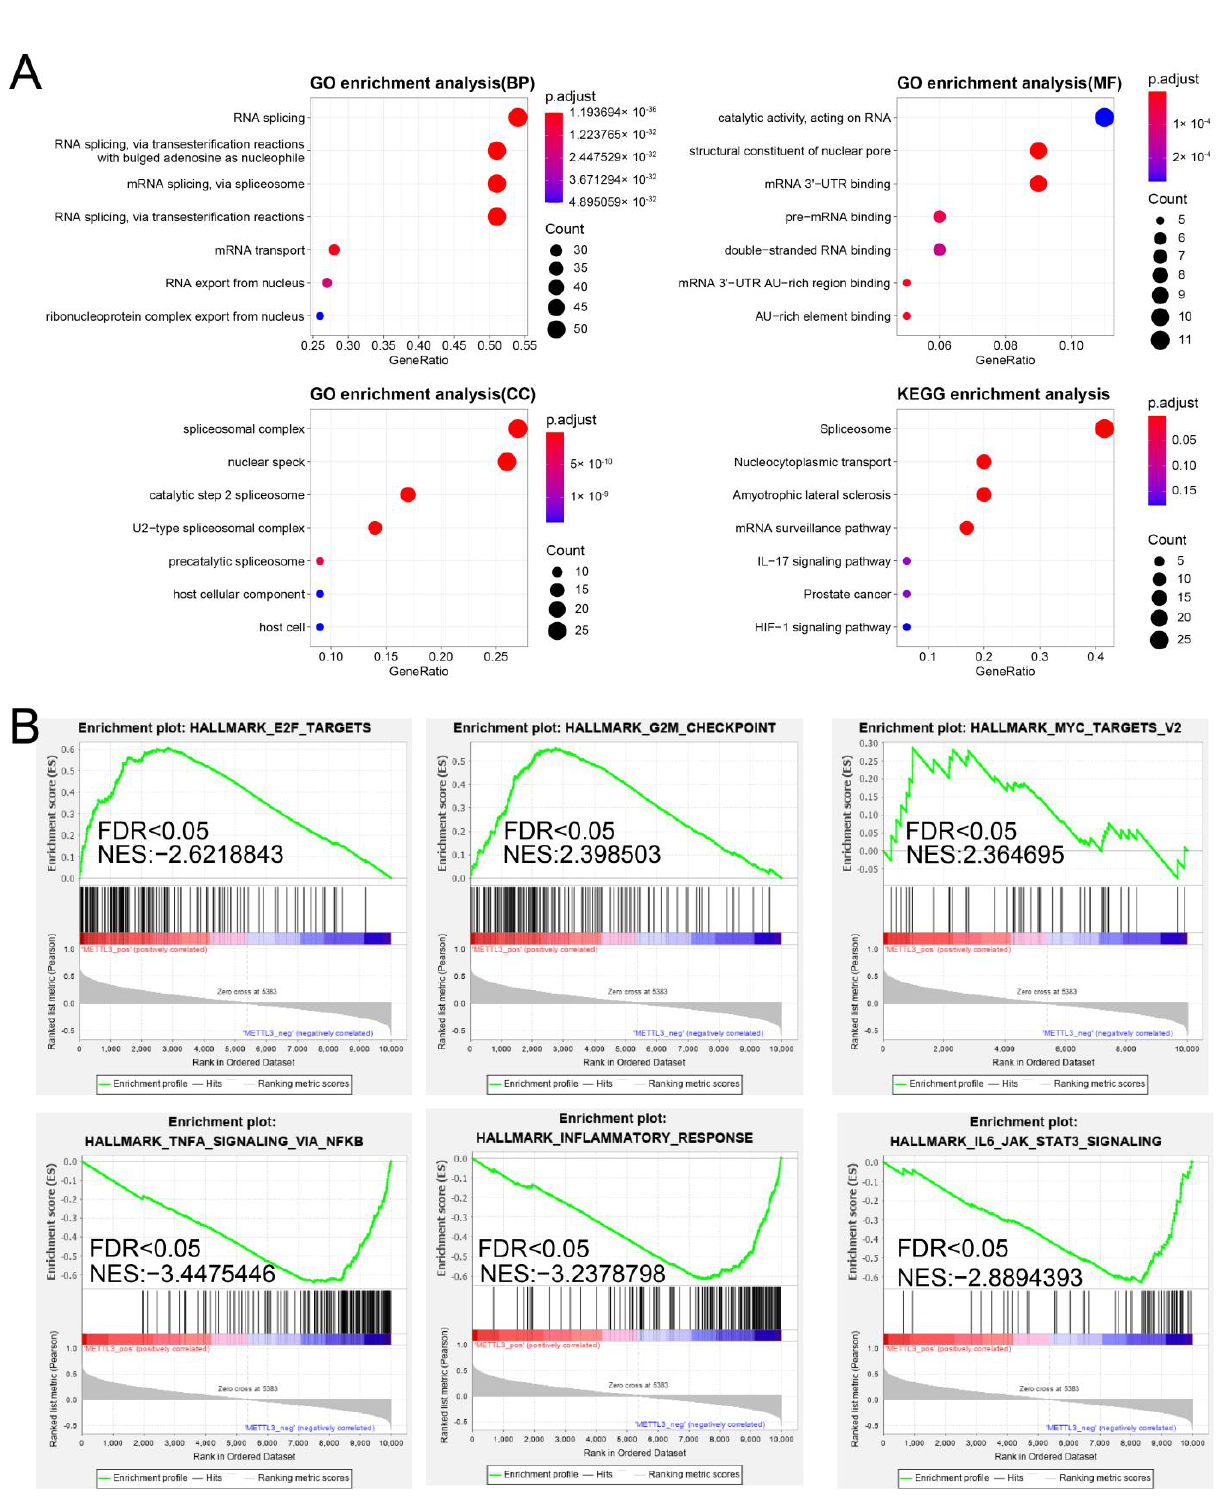
Figure 7. The biological function of the modification patterns of METTL3. ( A ) Top results of enrichment analysis. The gene ontology (GO) terms were under three categories, named biological processes (BP), cell components (CC), molecular functions (MF). KEGG, Kyoto Encyclopedia of Genes and Genomes KEGG pathways. ( B ) The top 3 of significantly positive and negative HALLMARK terms and normalized enrichment scores (NES) in the METTL3-m6A modification pattern in GSEA. FDR, false discovery rate., GSEA, gene set enrichment analysis.